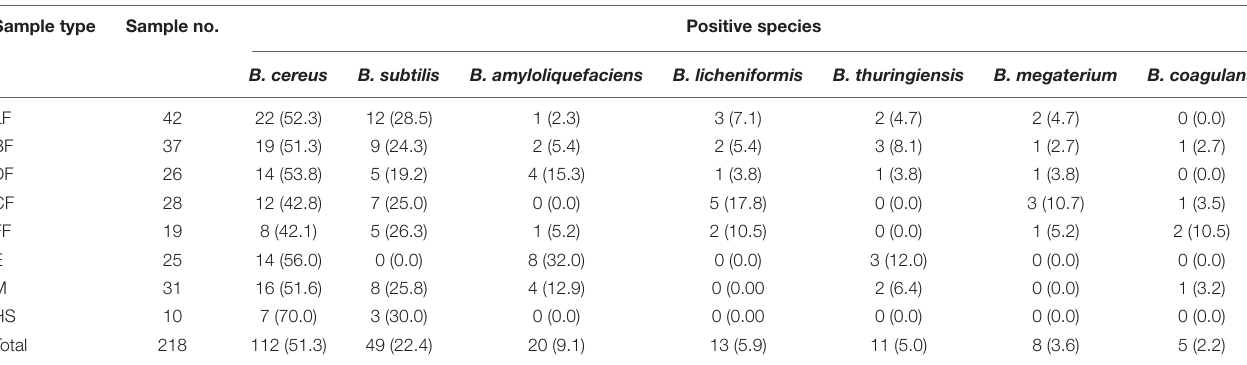
TABLE 4 | Positive Bacillus spp. isolated in different feed and other